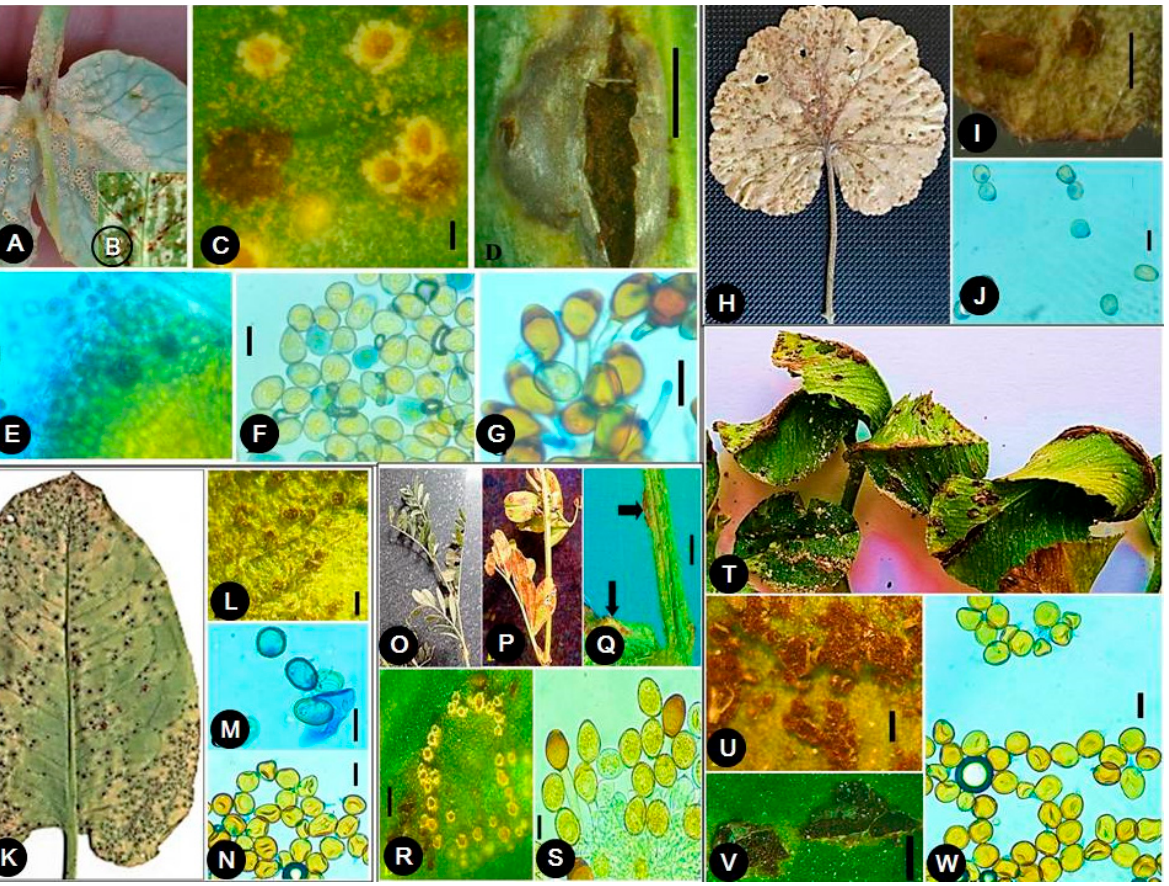
Figure 8. Occurrence of Uromyces species with some host plants. ( A – G ) Uromyces fabae on Pisum